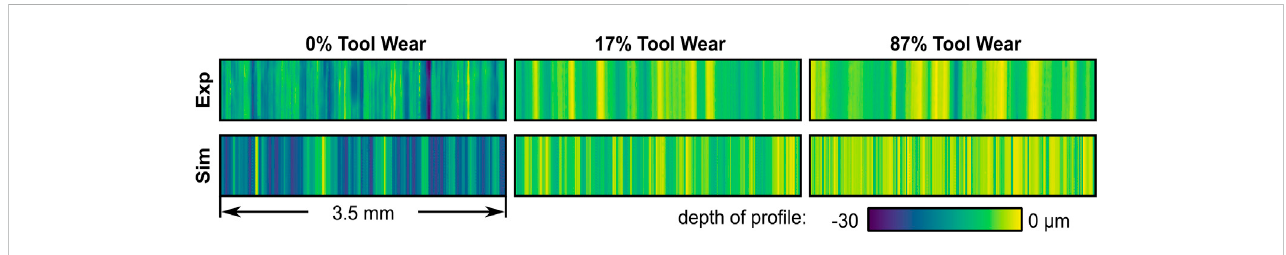
Frontiers in Manufacturing